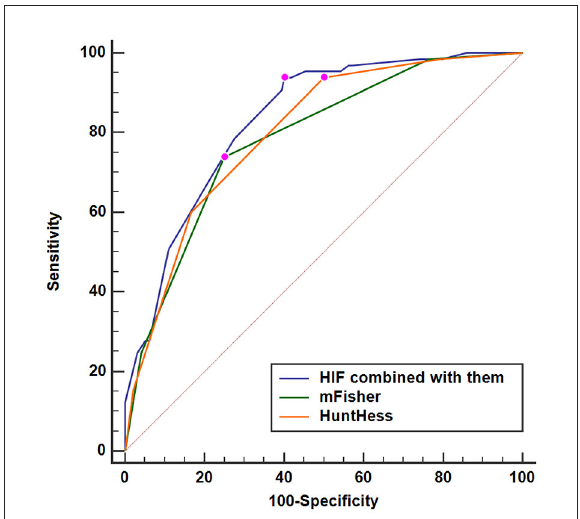
FIGURE7 Predictive ability with respect to serum hypoxia-inducible factor 1alpha levels combined with Hunt–Hess scores and modified Fisher scores for the risk of delayed cerebral ischemia. Serum HIF-1 α levels combined with Hunt–Hess scores and modified Fisher scores had significantly increased predictive ability for the risk of delayed cerebral ischemia, as compared to Hunt–Hess scores and modified Fisher scores alone ( P < 0.05). HuntHess, Hunt–Hess scores; mFisher, modified Fisher scores; HIF, hypoxia-inducible factor 1alpha.